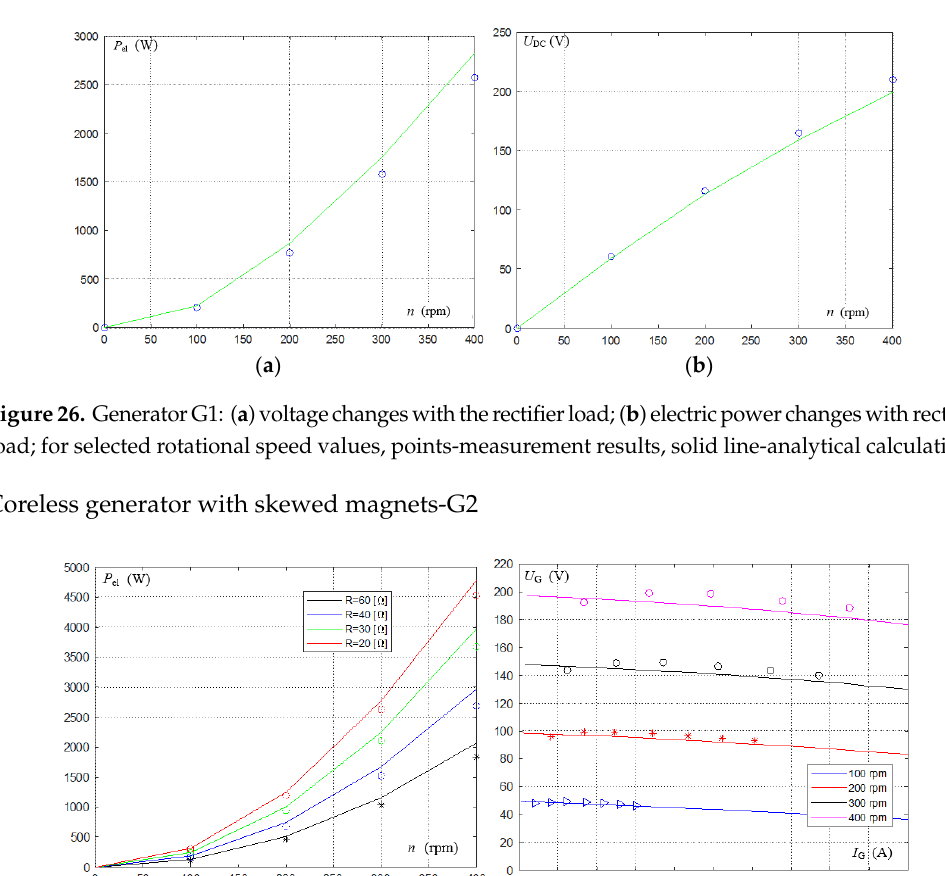
Figure 25. ( a ) Generator G1-power as a function of rotational speed for different resistive loads; ( b ) generator G1-voltage as a function of current for selected rotational speed values; points-measurement results, solid line-analytical calculations.